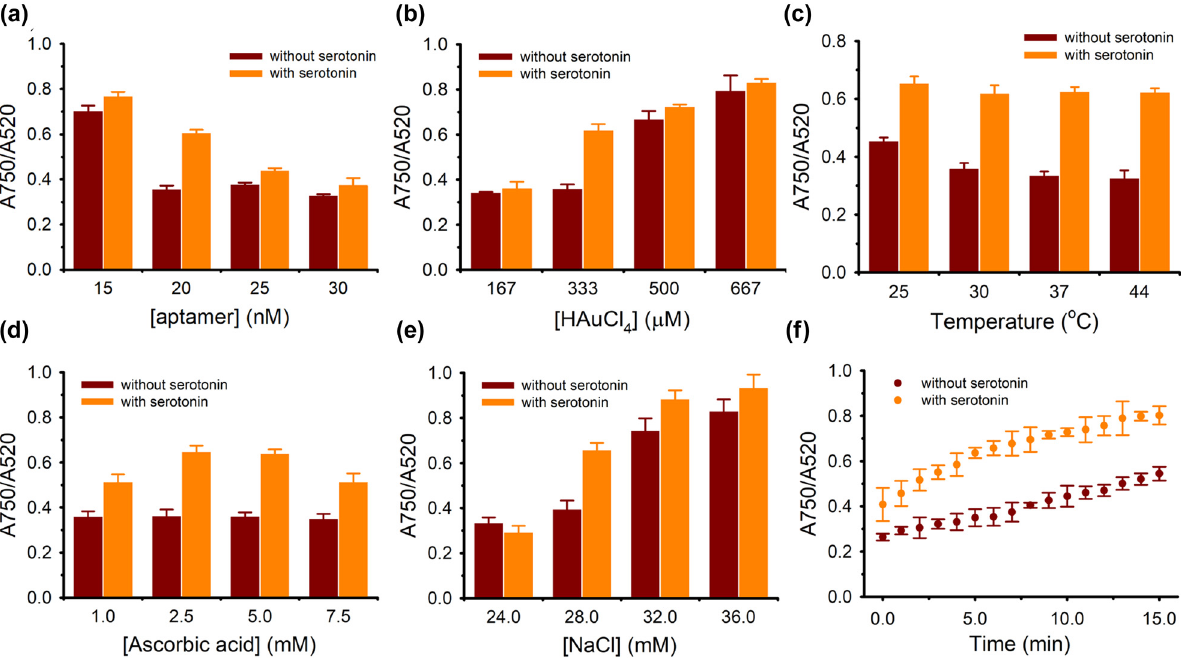
Figure 3: E ff ect of di ff erent condition parameters on the spectral responses with in situ prepared AuNPs in the presence and absence of 10 ng/mL serotonin: ( a ) aptamer concentration, ( b ) gold ion concentration, ( c ) reaction temperature, ( d ) ascorbic acid concentration, ( e ) NaCl concentration, and ( f ) the reaction time after the addition of NaCl. The error bars represent the standard deviation of the mean of three